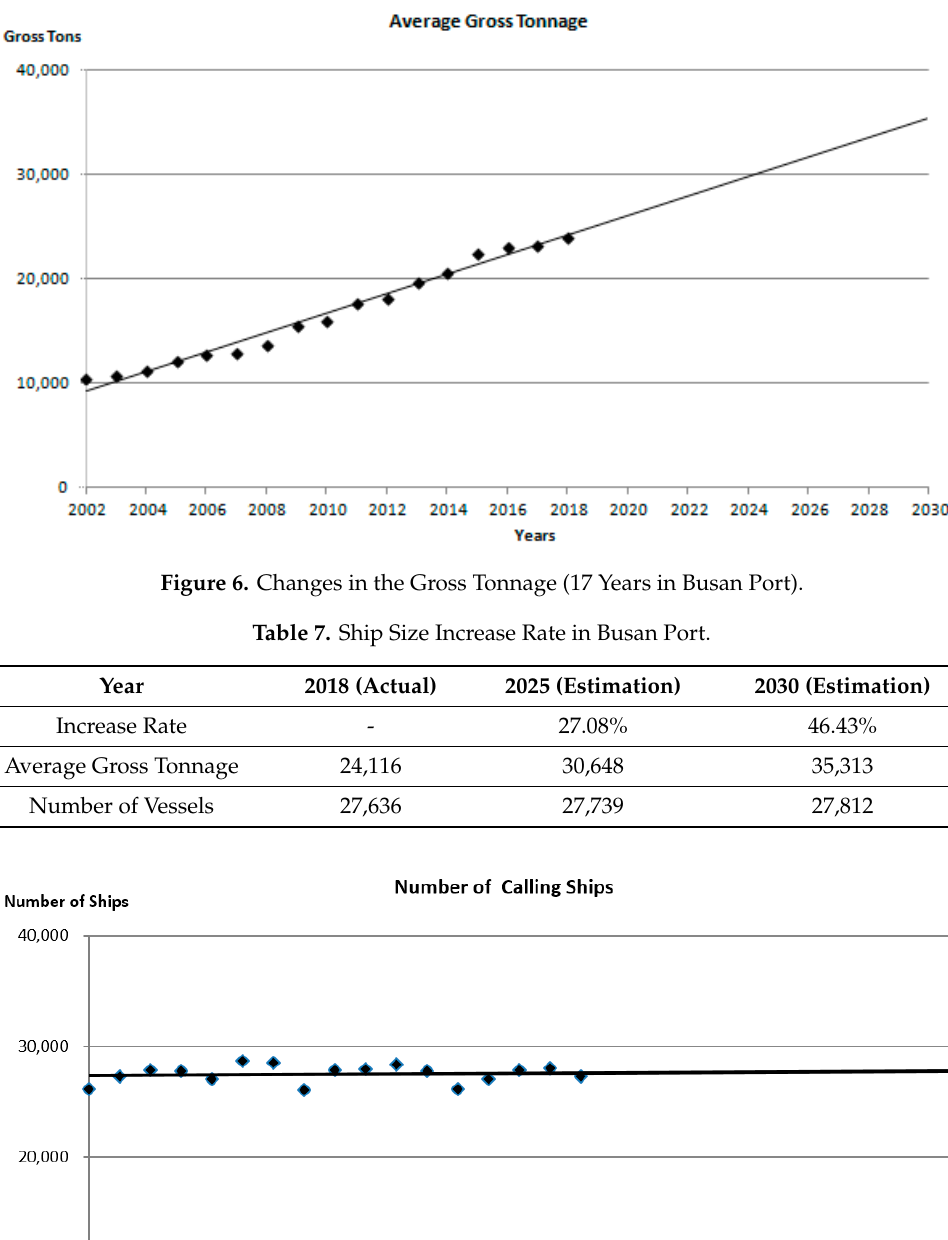
Table 6. Ship Analysis of Busan Port in 2018. Types of Ships